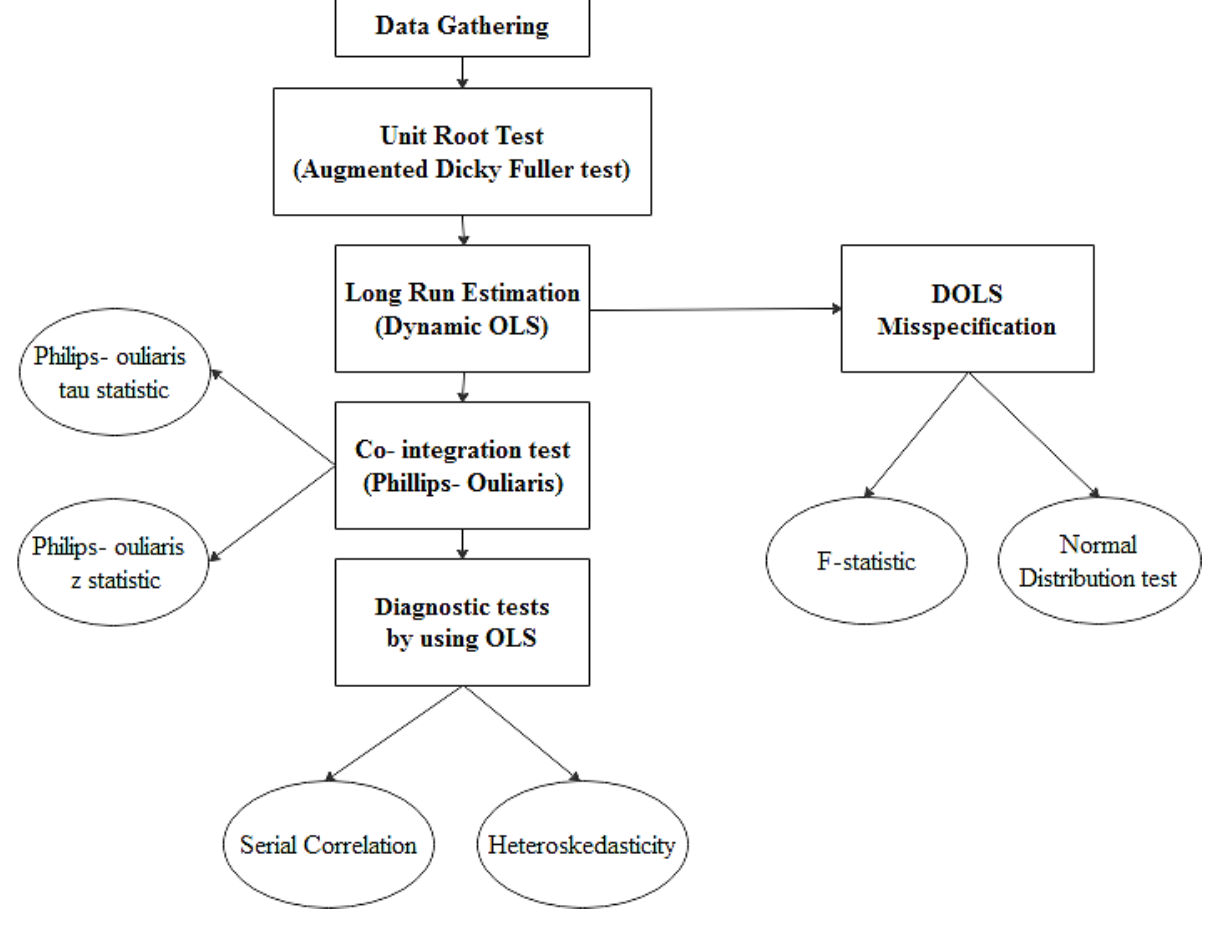
Figure 4. Flowchart of the research